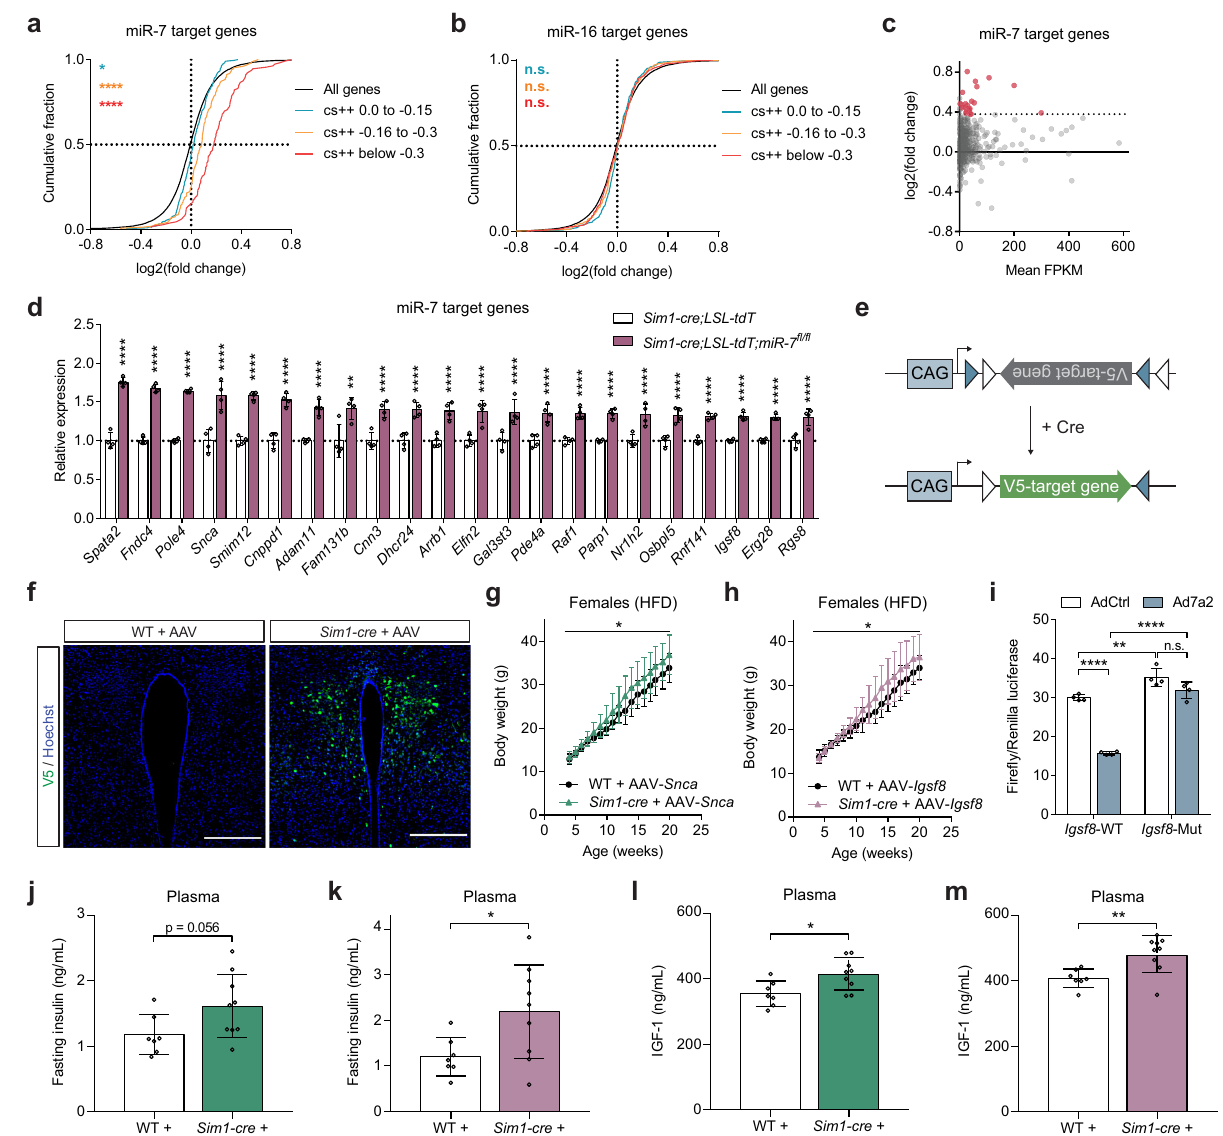
Fig. 5 | Identi fi cation of miR-7 target genes involved in Sim1 neuron function. a – b Cumulative frequency distribution of mRNA changes for predicted targets of miR-7 ( a ) or miR-16 ( b ) in Sim1-cre;LSL-tdTomato;mir-7 fl / fl versus Sim1-cre;LSL- tdTomato RNA sequencing data. Targets are binned by cumulative weighted con- text++ score (cs++) and compared to all expressed genes. Number of genes per binformiR-7:black,16830;blue,225;orange,149;red,112.Numberofgenesperbin for miR-16: black, 16830; blue, 332; orange, 408; red, 425. c log2(fold change) and meanFPKM(fragmentsperkilobaseoftranscriptpermillionfragmentsmapped)of allpredictedconservedmiR-7targetgenesin Sim1-cre;LSL-tdTomato;mir-7 fl / fl versus Sim1-cre;LSL-tdTomato RNA sequencing data. Targets with >1.3-fold upregulation are shown in red. d Expression (relative to Sim1-cre;LSL-tdTomato ) of upregulated targets in Sim1-cre;LSL-tdTomato;mir-7 fl / fl versus Sim1-cre;LSL-tdTomato RNA sequencing data ( n =4 samples, with 4 mice pooledpersample). e Strategyof Cre- dependent target overexpression using a pAAV-FLEx vector. f V5 immuno- fl uorescence in the PVN of WT (representative of 3 mice) and Sim1-cre mice expenditure was slightly reduced in mice with Snca overexpression (Supplementary Fig. 8x, y). Taken together, overexpression of Snca and Igsf8 in Sim1 neurons each partly recapitulates the phenotype of Sim1-cre;mir-7 fl / fl mice. These data identify Snca and Igsf8 as direct targets of miR-7 that play a functional role in Sim1 neurons to regulate body weight and endocrine axes.